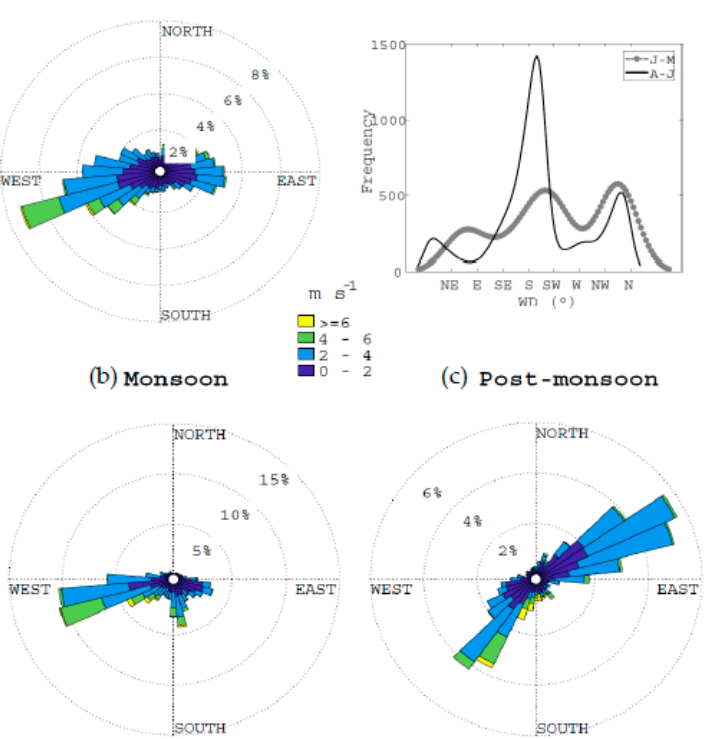
Figure 2. The wind rose for the three studied seasons ( a ) pre-monsoon, ( b ) monsoon, and ( c ) post-monsoon. In panel (a) probability density function (PDF) from January (J) to March (M)—thin black line, and from April (A) to June (J)—thick gray line.